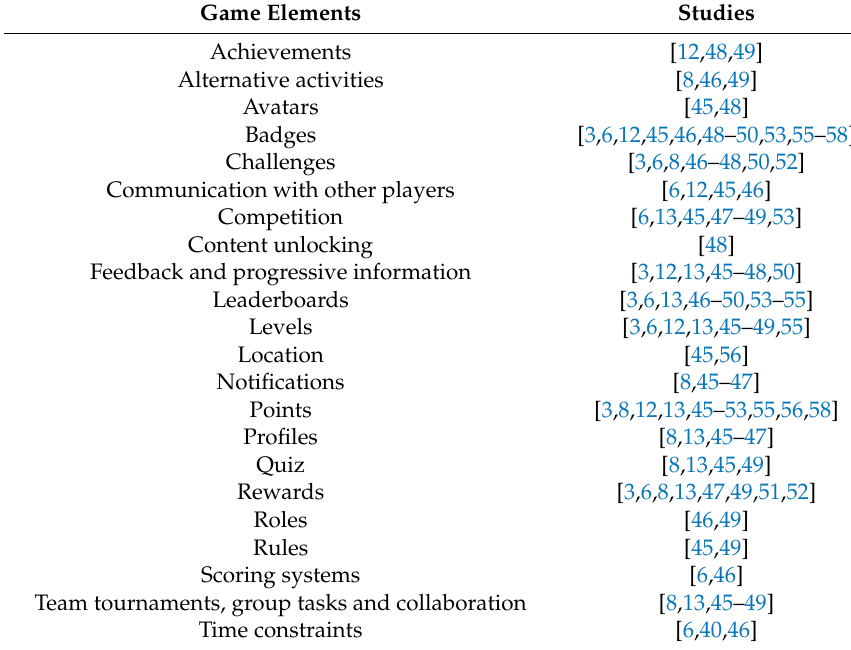
Table 1. Game elements considered by each